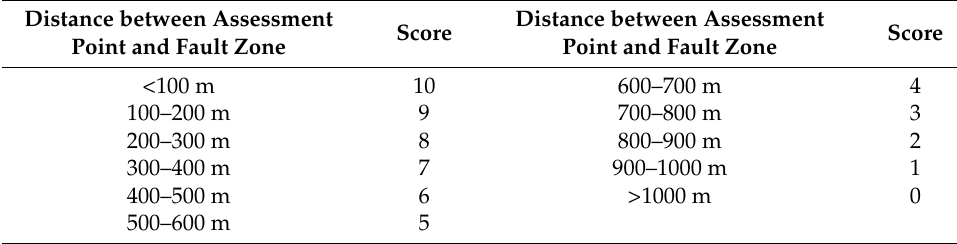
Table 4. Scoring criteria for fault assessment.